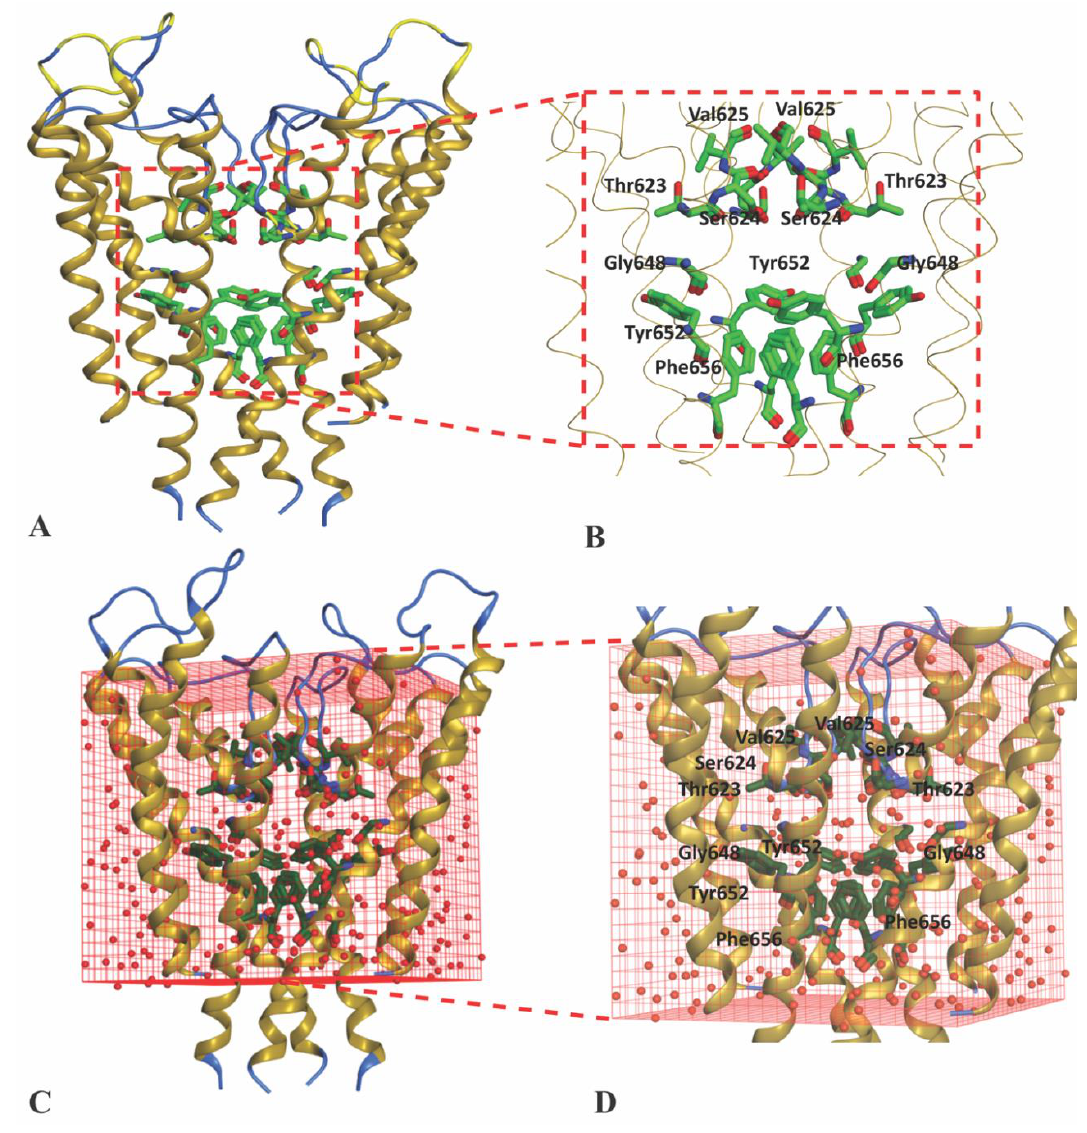
Figure 2. Closed conformational state of hERG homology model based on KcsA template. ( A ) Closed conformational state of homology model with highlighted non-solvated-closed binding cavity. ( B ) Zoom-in view of non-solvated-closed binding cavity showing mutagenesis amino acid residues. ( C ) Solvated-closed conformational state of hERG homology model. ( D ) Zoom-in view of solvated-closed hERG binding cavity showing mutagenesis residues and water molecules.